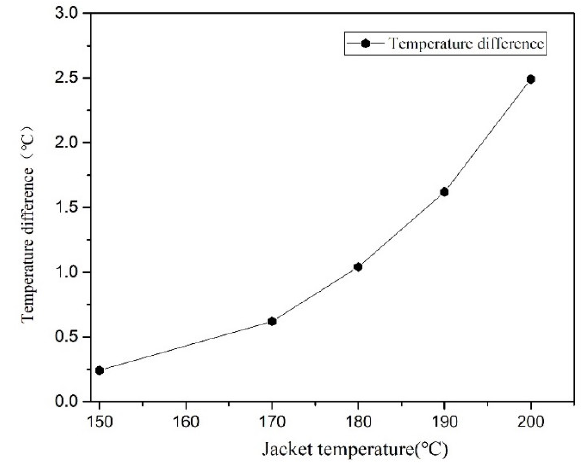
Figure 13. Polymer conversion rate curves at different jacket temperatures.